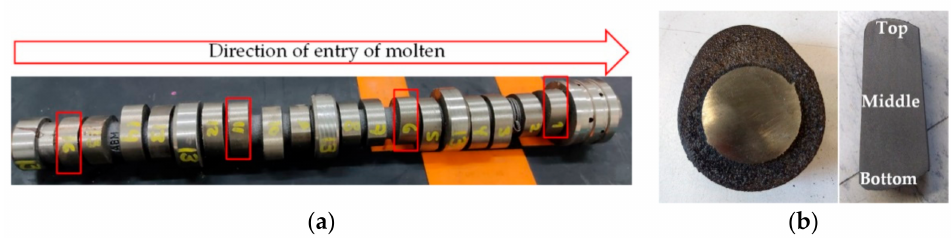
Figure 2. ( a ) Camshaft with 16 lobes and ( b ) regions analyzed from the top to the bottom of the